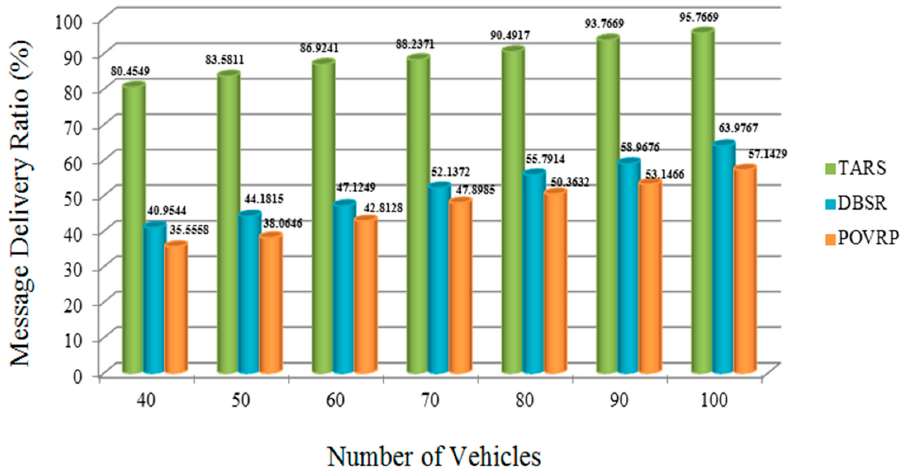
Figure 13. Message Delivery Ratio w.r.t. the Varied Vehicle Density in the highway scenario.